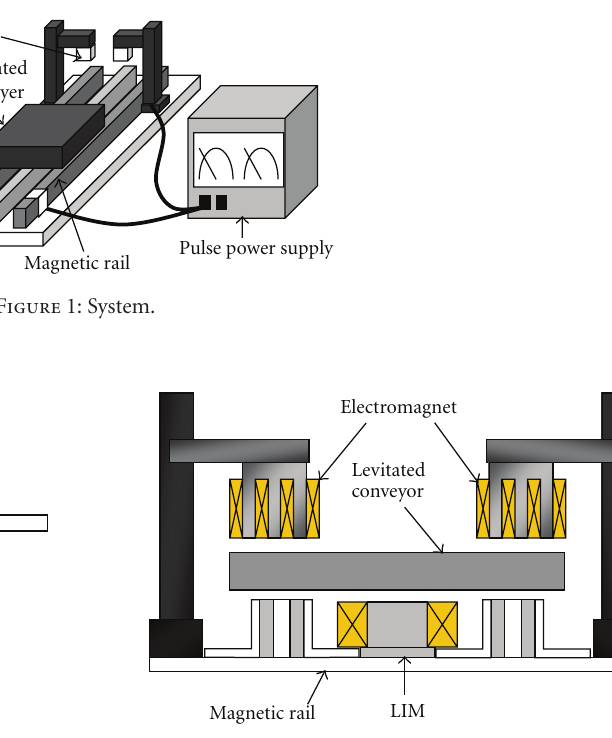
Figure 4: Magnetization method.